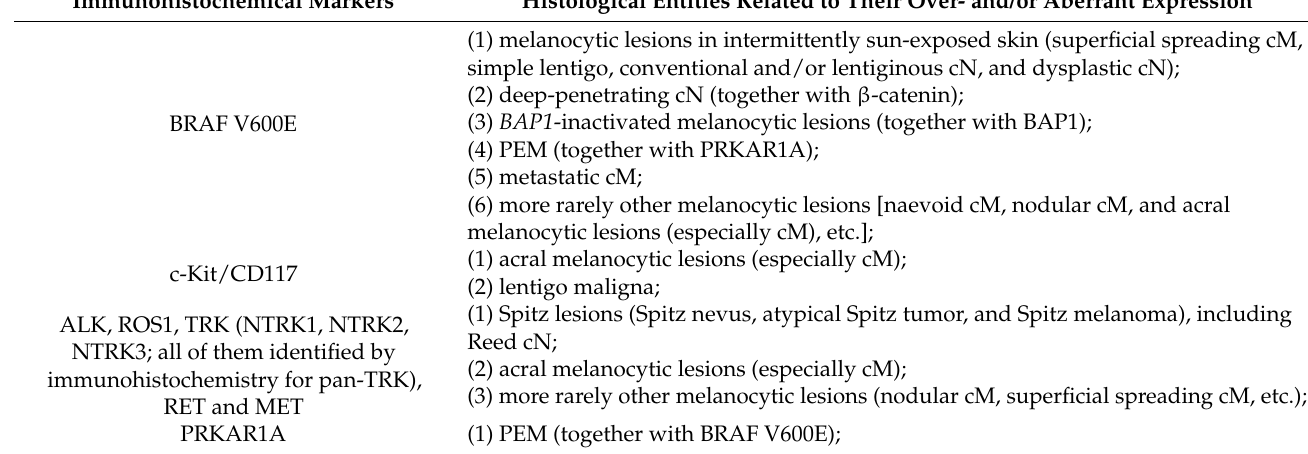
Table 2. Summary of the immunohistochemical markers useful for the identification of specific histological subtypes of cN and